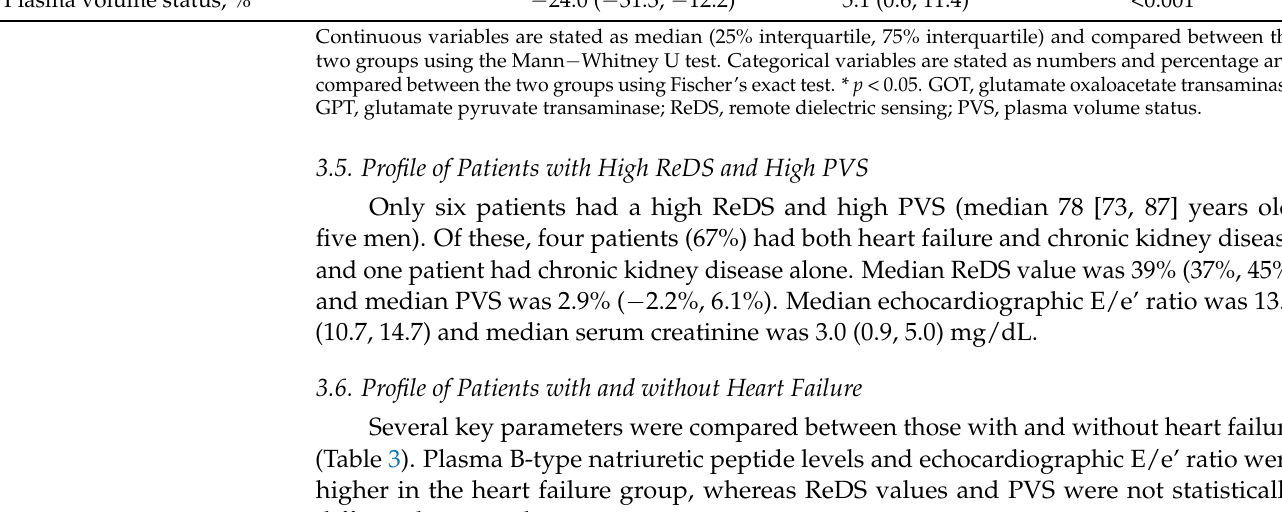
(Table 3). Plasma B-type natriuretic peptide levels and echocardiographic E/e’ ratio were higher in the heart failure group, whereas ReDS values and PVS were not statistically different between the two